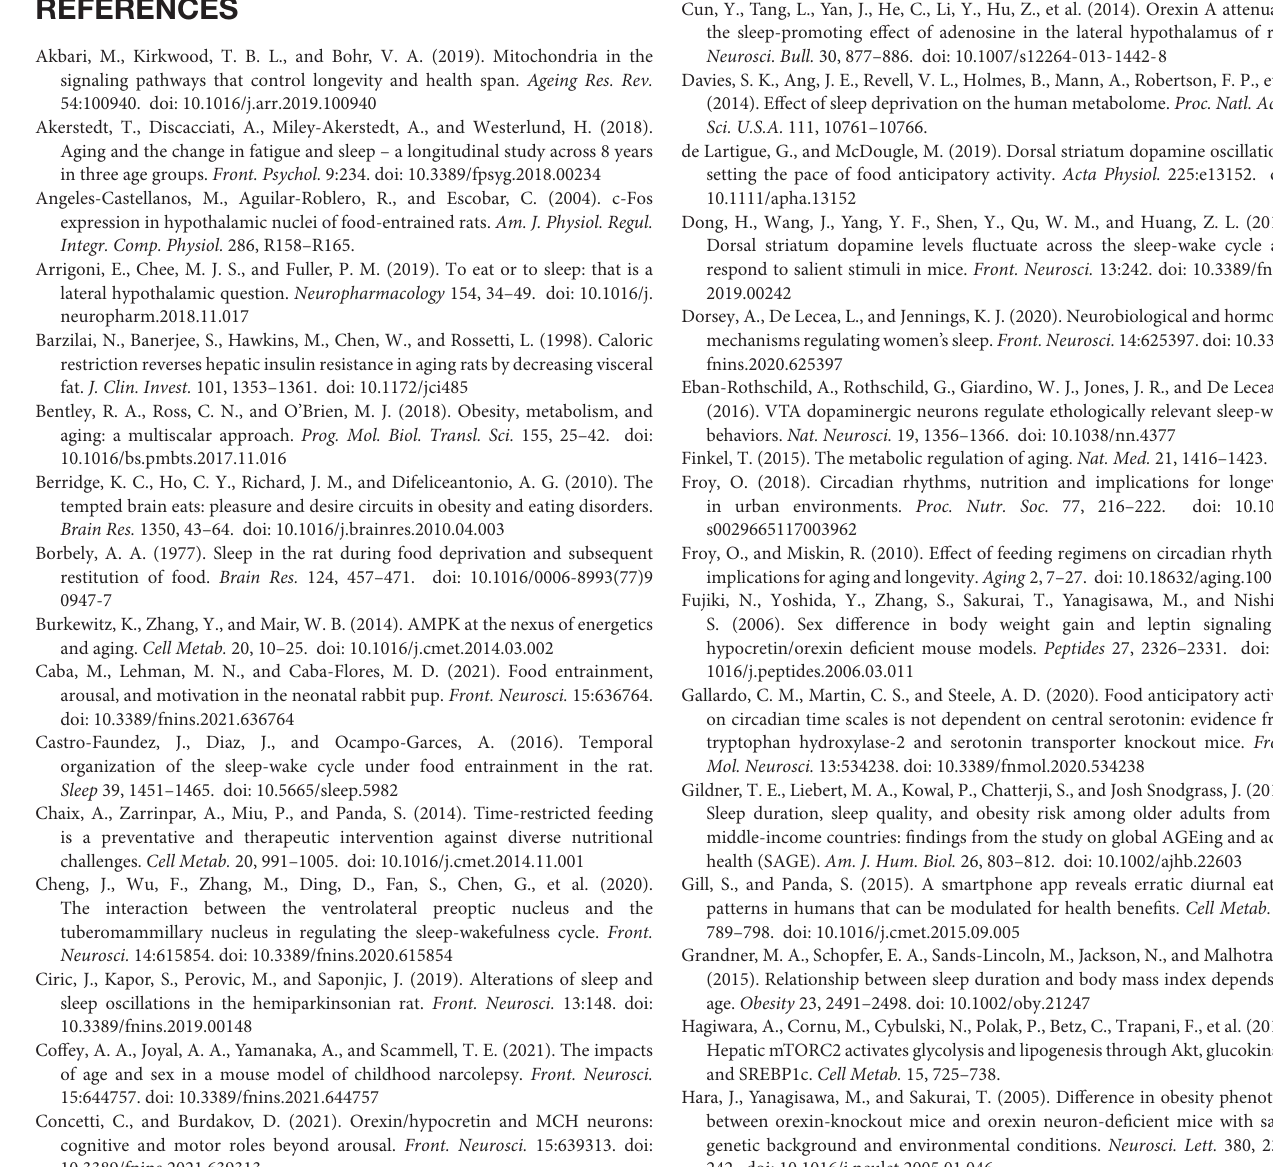
NREM sleep (B) , and REM sleep on day 14 of the RF protocol (C) . Cumulative time of wakefulness, NREM sleep, and REM sleep during the light period (D) , dark period (E) , and 24-h period (F) . The gray box indicates food availability during the dark period. Open and closed bars above the x -axis indicate light and dark periods, respectively. ∗∗ p < 0.01 versus CTRL, n = 6. CTRL, control; RF, restricted feeding. Supplementary Figure 3 | Sleep-wake architecture in the RF and CTRL groups on day 0 of the RF protocol. The mean durations of wakefulness, NREM sleep, REM sleep (A) , and number/type of episode during each stage (B) during the 10 h of the light period (08:00–18:00). (C) Transitions between stages during the 10 h of the light period, n = 6. CTRL, control; RF, restricted feeding; R, REM sleep; S, slow-wave sleep; W, wakefulness. Supplementary Figure 4 | Sleep-wake architecture in the RF and CTRL groups on day 14 of the RF protocol. The mean durations of wakefulness, NREM sleep,